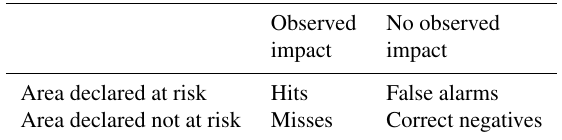
Table 2. Contingency